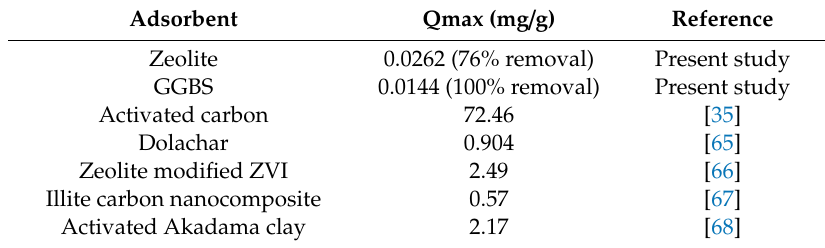
Table 4. Comparison of maximum removal capacity of Cr(VI) by various adsorbents.